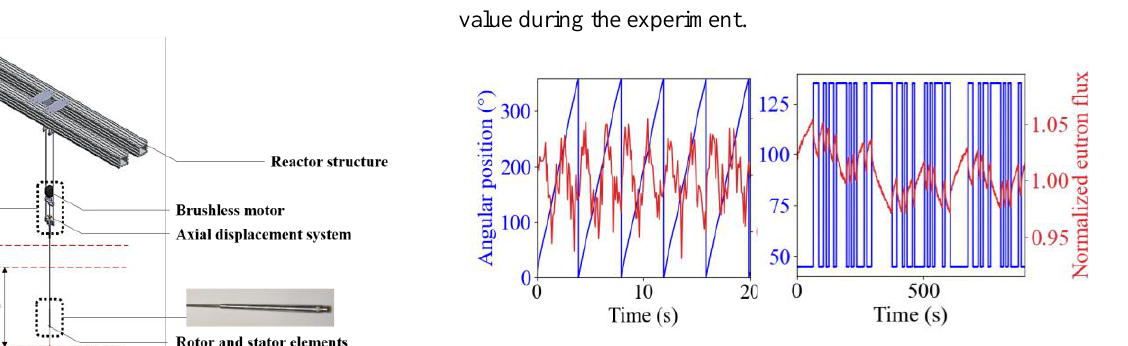
Figure 7. Measured motion profile of PISTIL in blue and the measured modulation amplitude in red for the continuous rotation (left) and the stepwise movement (right). Time is normalized to the period of the